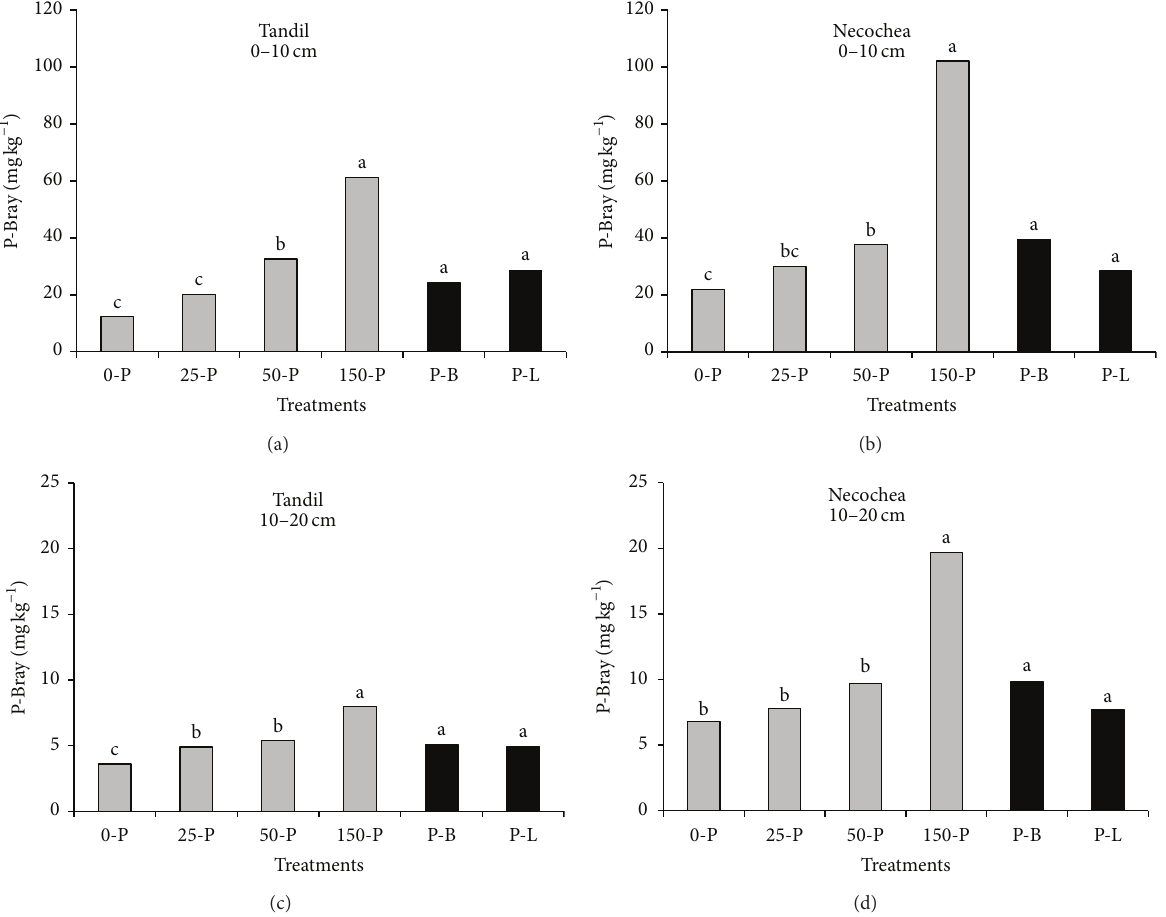
Figure5:AvailablesoilP-Brayattillering(0–10and10–20 cm)affectedbyplacementmethodandPrate.Meansfollowedbythesameletterare not significantly different from each other based on the LSD test (0.05). Phosphorus response is compared using 25, 50, and 150P rates (gray). Phosphorus placement method is only compared at 25 and 50 P rates. P-B: phosphorus broadcasted. P-L: phosphorus banded at